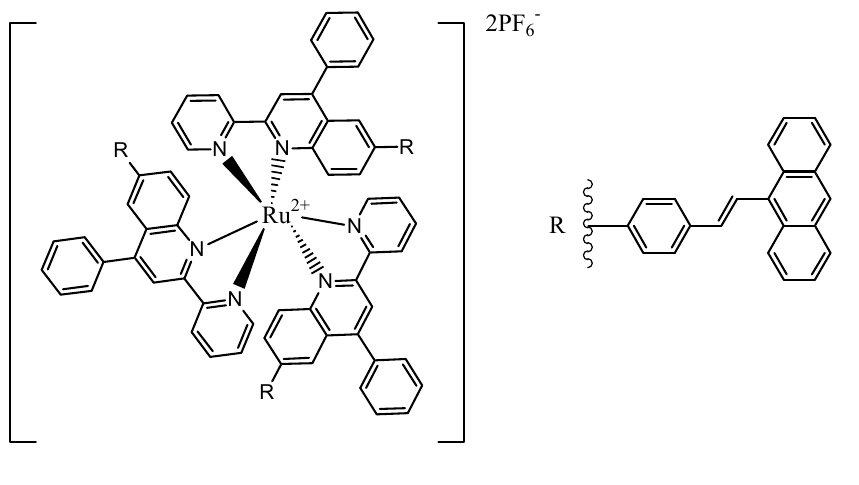
Figure 27. Structure of [Ru(LP1) 3 ][PF 6 ] 2